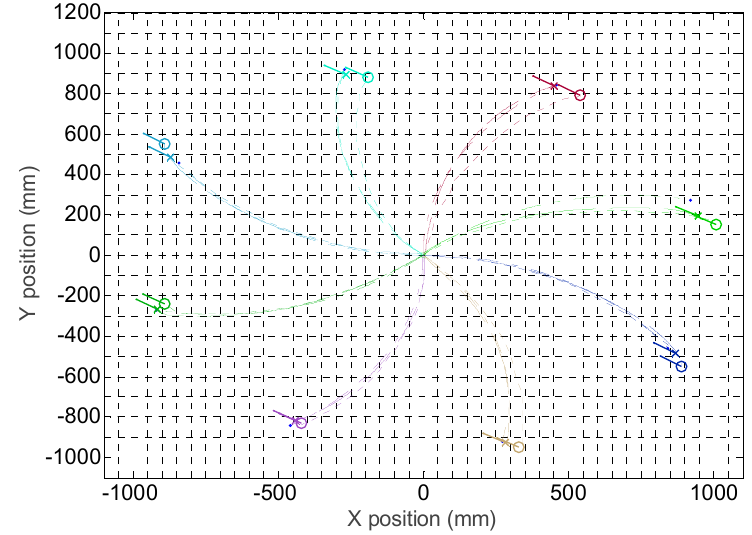
Figure 28. Trajectories followed by the mobile robot in eight displacements. The circle depicts the final position and orientation of the mobile robot obtained with the SLAM procedure. The cross depicts the final position and orientation of the mobile robot according the information of the encoders and the kinematic model.